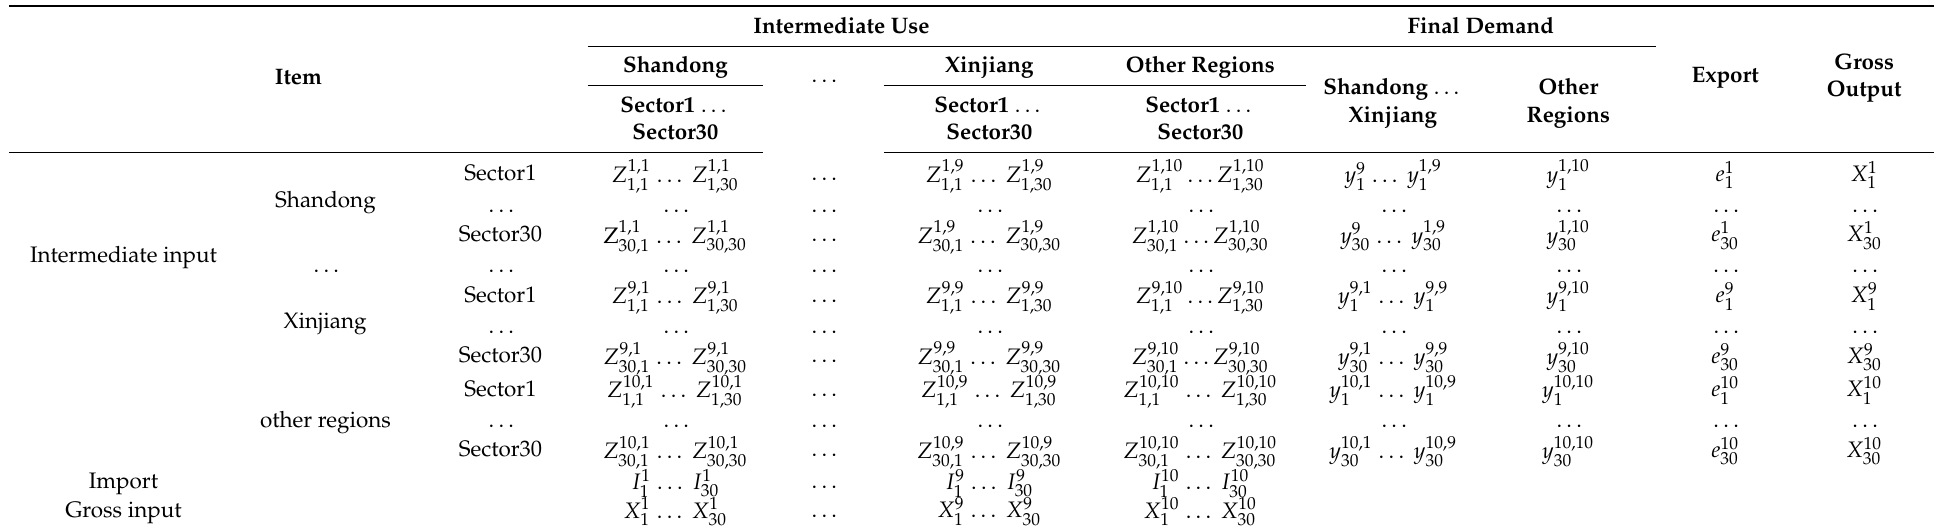
Table 2. Input and output of multiple regions in the Yellow River Economic